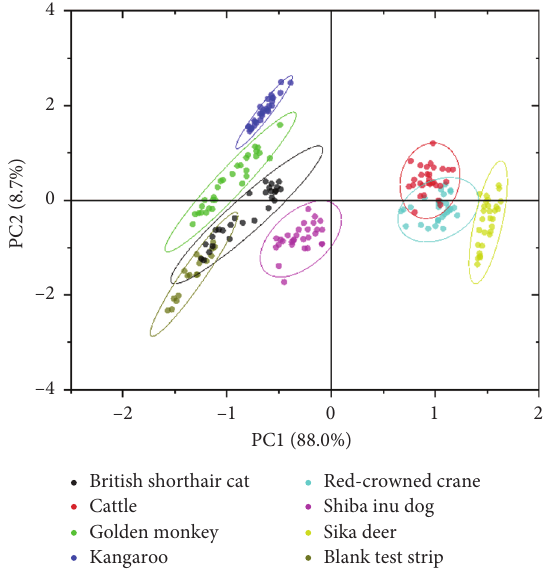
Figure 6: The PCA results of the Raman spectra of seven species of animal blood samples with 95% confident